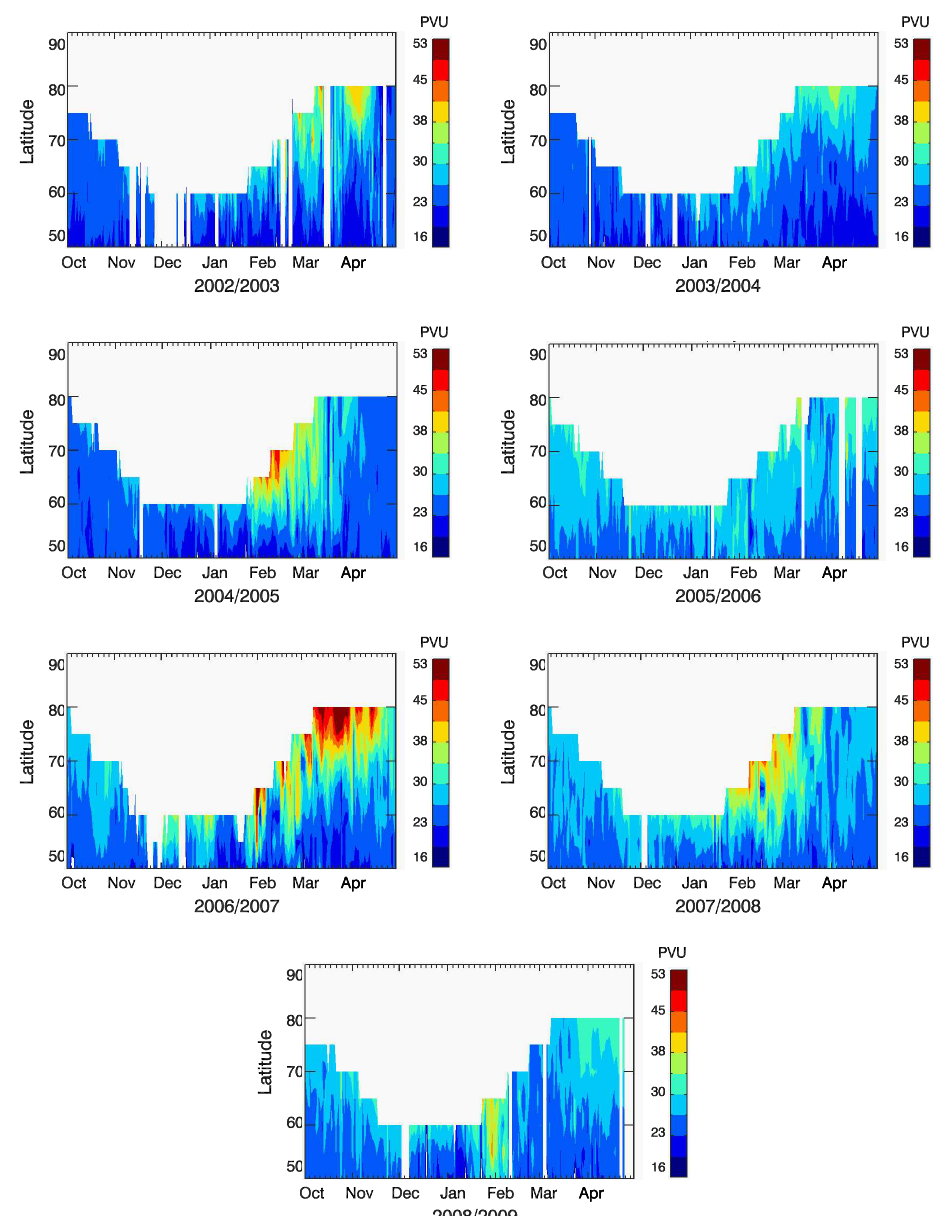
Fig. 1. Daily and zonally averaged modified potential vorticity at the 475K isentropic level in the Arctic stratosphere for latitudes of SCIAMACHY observations in 2002–2009 during winter/spring (given in potential vorticity units (PVU)). Data averaged over 5 ◦ latitude bins.